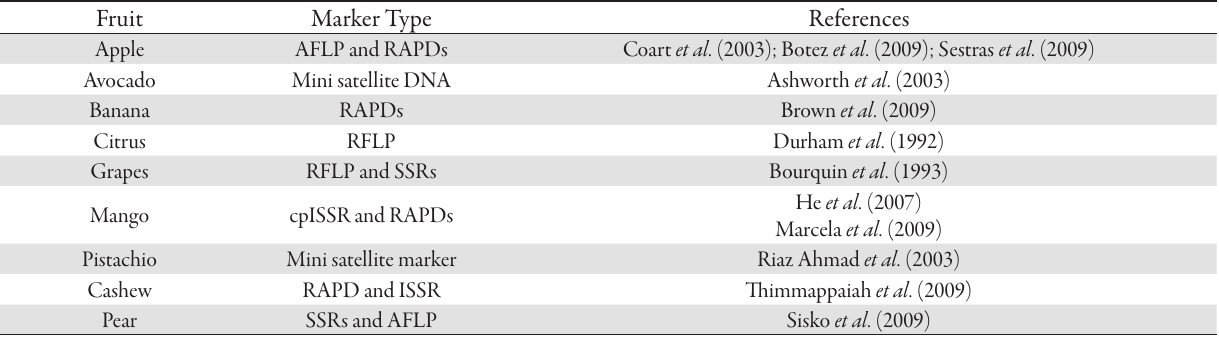
Tab. 5. DNA Markers for Genetic Diversity Assessment in Fruit Crops Fruit